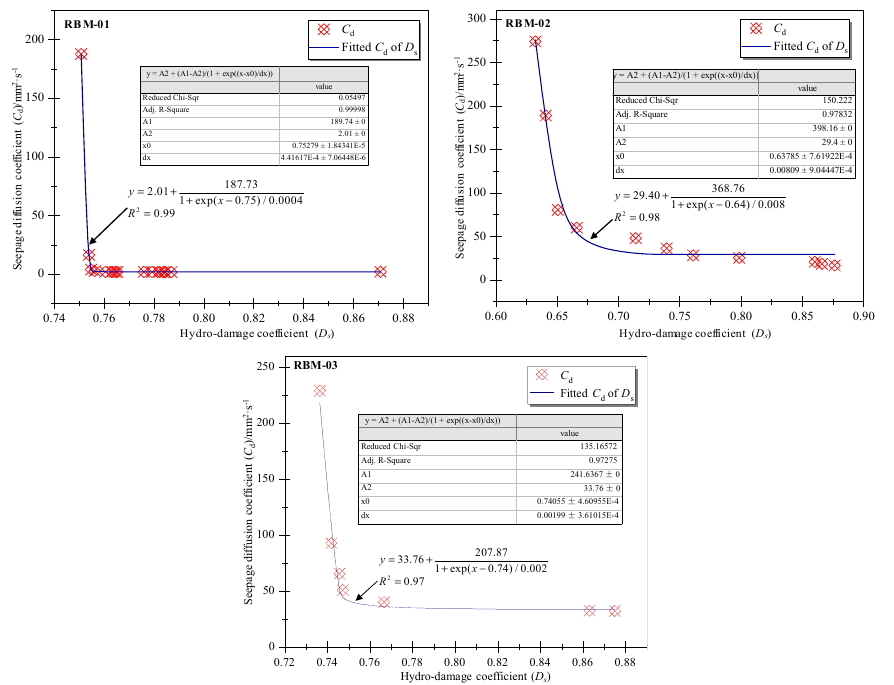
Figure 10. Fitting relation between the hydro-damage factor and seepage-diffusion coefficient.